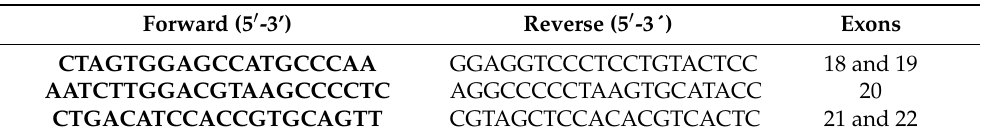
Table 4. Primers for genomic DNA amplification and sequencing, covering the feline her2 TK domain, between exon 18 to exon